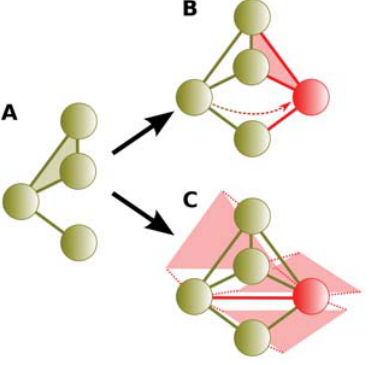
Figure 7. Triangles and connected triples in gene duplication. (A) The network has T =1 triangle and C =5 connected triples. (B) Simple duplication adds a duplicate of the progenitor’s single triangle to the network. There are c p = k p ( k p 2 1)/2=3 connected triples centered around the progeny, and an additional S k g =5 connected triples centered on the neighbors. (C) If the progenitor is self-interacting, an additional edge between the progenitor and progeny is formed, thus increasing the simple duplication counts by k p =3 additional triangles (extruded for clarity) and 2 k p additional connected triples (the progenitor and progeny are both centered on k p additional connected triples due to the dimerizing interaction).